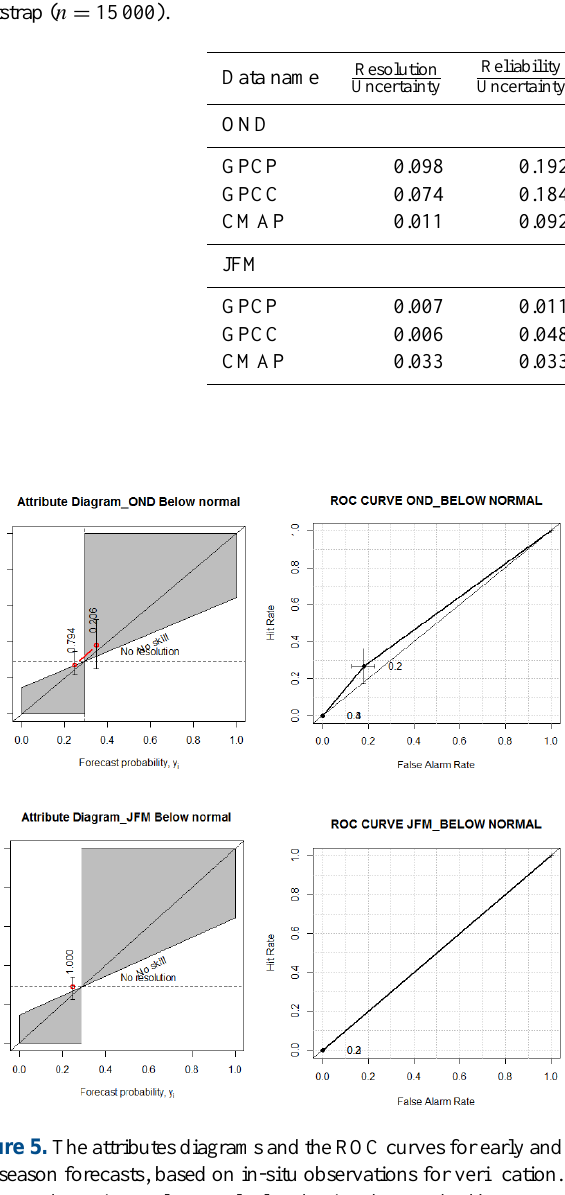
Table 1. For the early and late season, BSS, its decomposition terms, and its CI for different data sets. The CIs are calculated using the block bootstrap ( n = 15000).